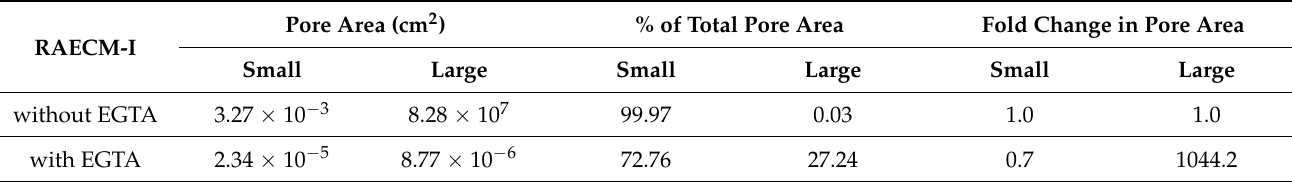
Table A4. Equivalent pore characteristics in response to EGTA treatment. Entries are based on the estimated values listed in Table A3. Equivalent pore area is per nominal surface area (1 cm 2 ) of RAECM-I.